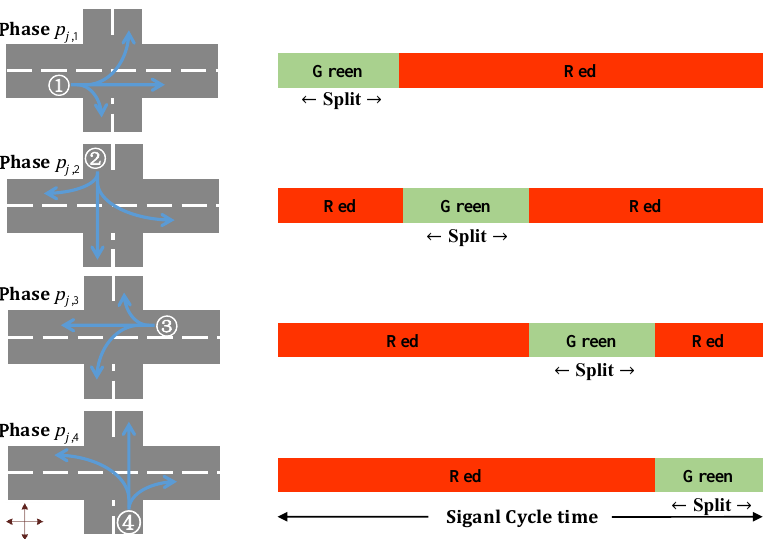
Figure 3. Phases of intersection j